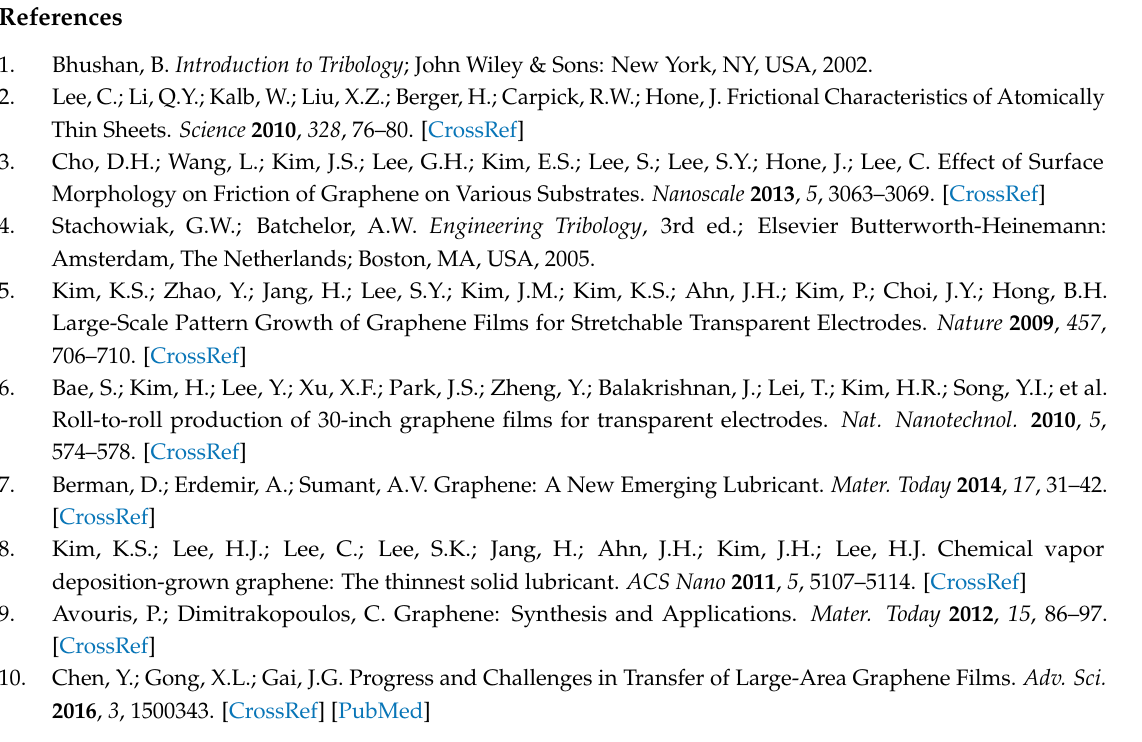
Figure S1: Raman spectra of (a) MoS 2 and (b) graphene samples. The thickness of prepared MoS 2 samples corresponds to 2L, 4L, and 12L thickness. Graphene corresponds to 1L thickness, Figure S2: Optical images taken from the bare SiO 2 and 1L graphene samples after 20 sliding cycles on macro-scale. After 20 sliding cycles, sever wear damages were observed on 1L graphene samples. This indicates that the tested 1L graphene cannot protect sliding